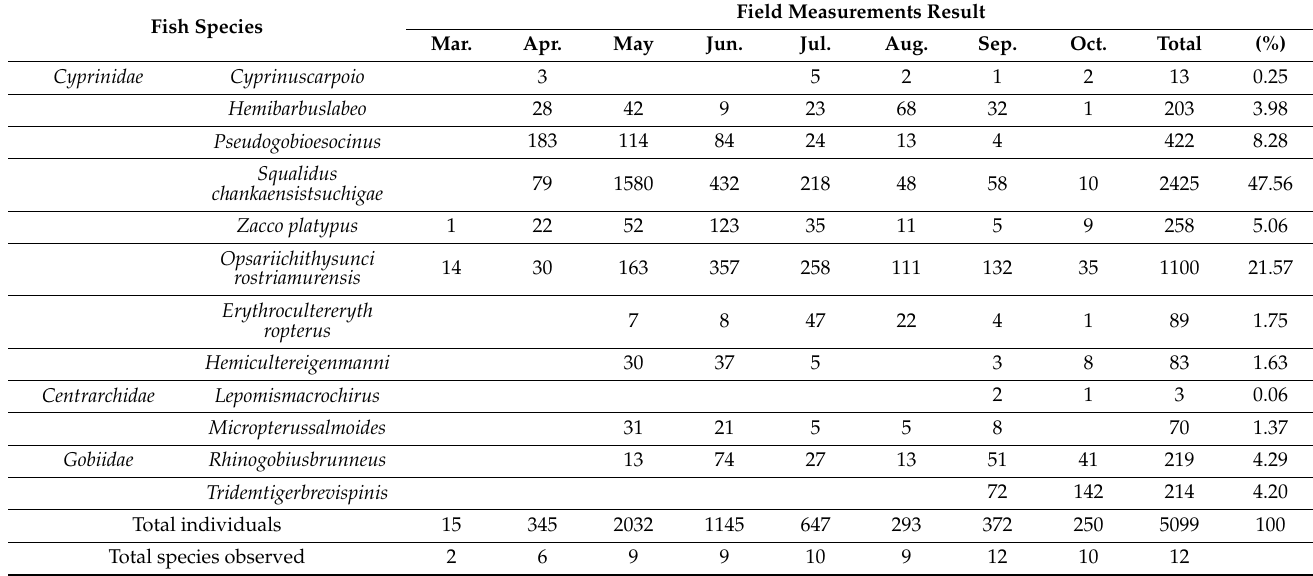
Table 3. Fish monitoring results at the exit of the